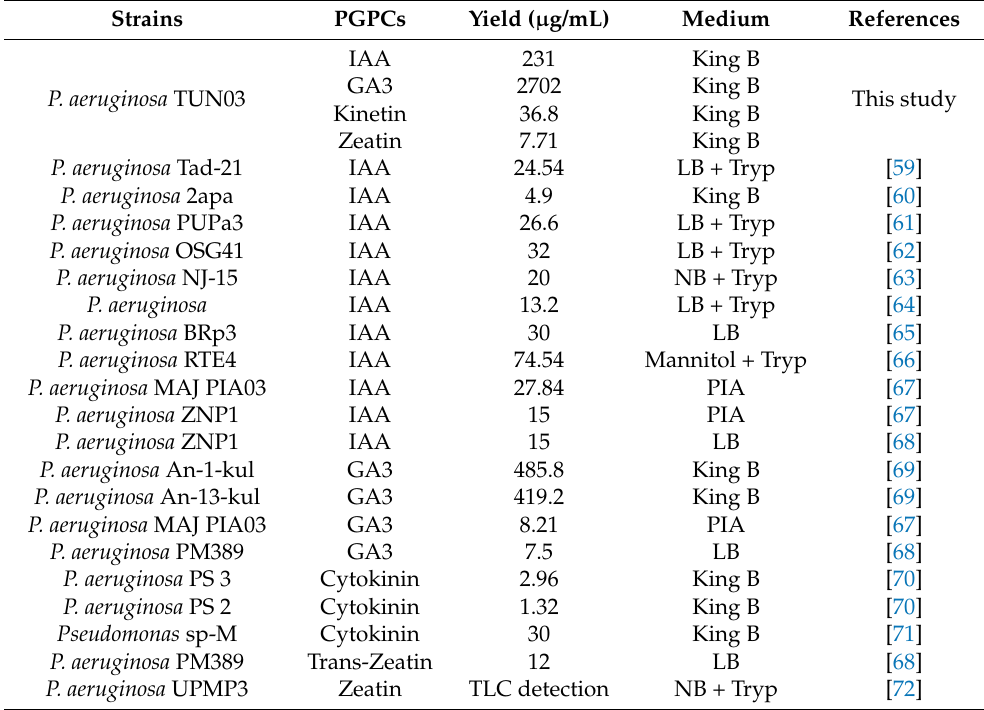
Table 5. A comparison of plant-promoting compounds (PGPCs) produced by Pseudomonas aeruginosa strains in different studies.